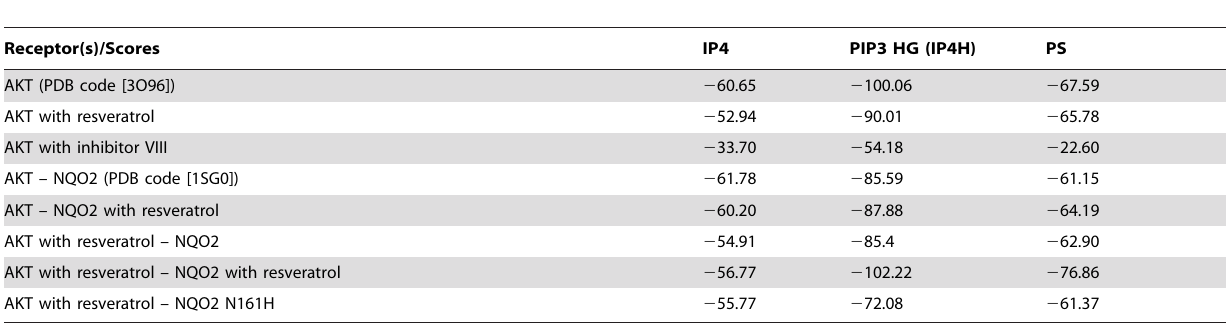
Table 1. Determination of the binding of AKT activators, Ins(1,3,4,5)P4 (IP4), PtdIns(3,4,5)P3 (PIP3) or phosphatidylserine (PS) to AKT using small molecule